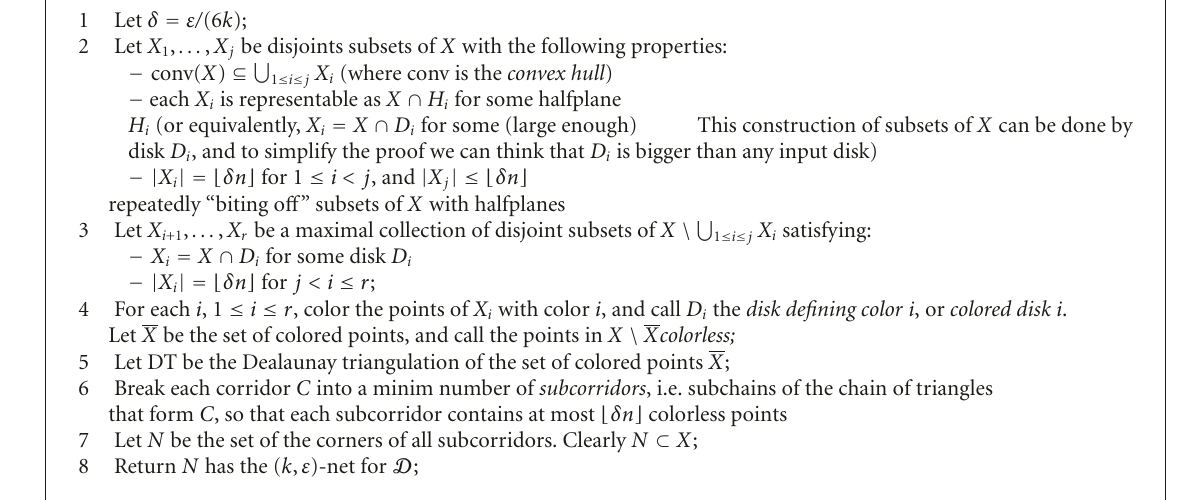
Algorithm 2: Small ( k , ε )-nets for